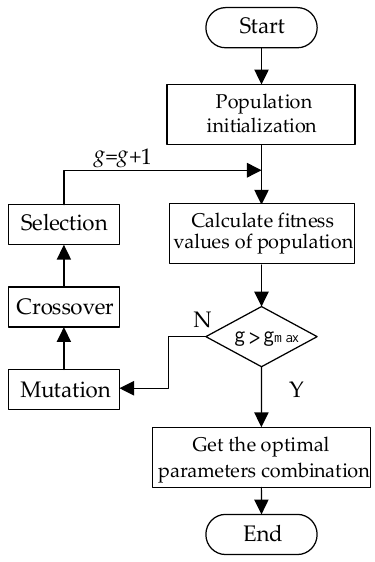
ff erential evolution (DE) Figure 5. Flow chart of the differential evolution (DE) algorithm. Figure 5. Flow chart of the di